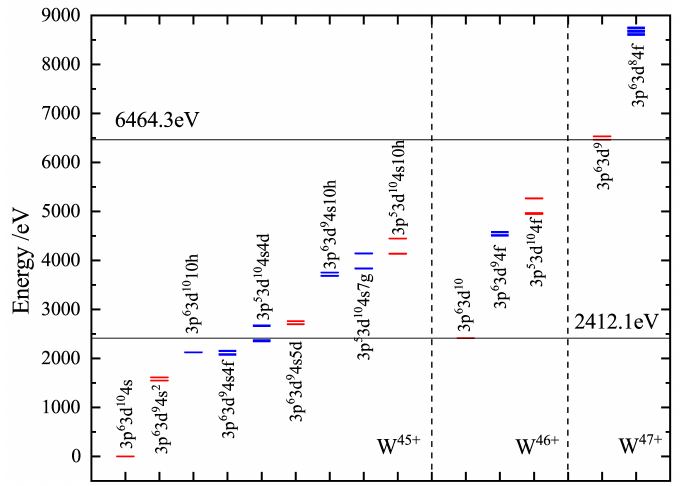
Figure 1. Energy levels of the major configurations of W 45 + , W 46 + , and W 47 + ions that we calculated relevant to this study. Even configurations are shown in red; odd configurations are shown in blue. Horizontal lines: the thresholds for single and double ionization of W 45 +